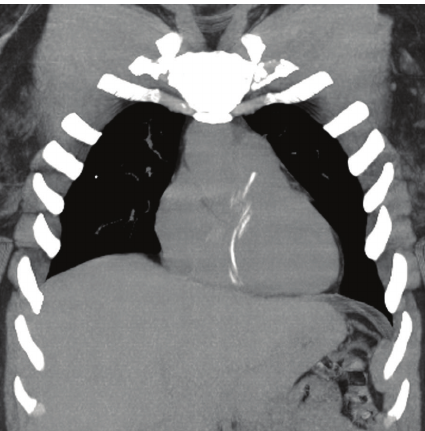
Figure 1: Coronal reformat noncontrast CT MIP image demon- strates the dislodged catheter extending from the right atrium through the right ventricle terminating in the pulmonary outflow tract.